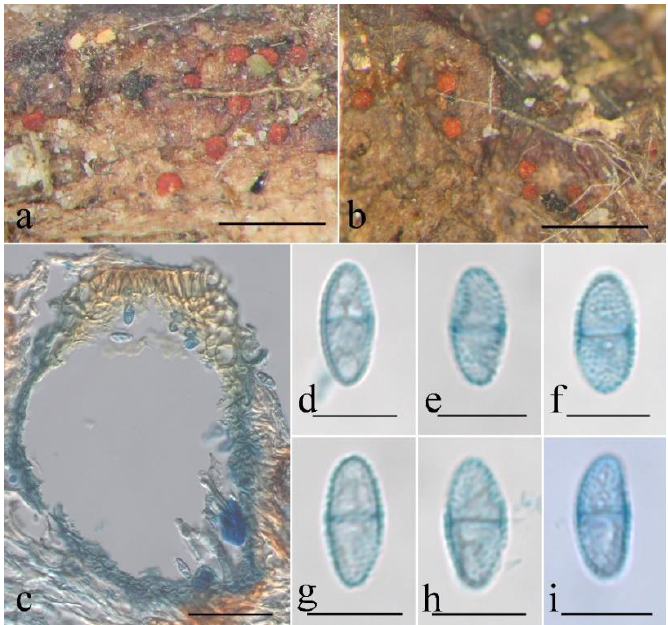
Figure 10. Macroscopic and microscopic morphology of Thelonectria spinulospora (HMAS 290897). ( a , b ) Ascomata on natural substratum; ( c ) median section of perithecium in lactophenol cotton blue; ( d – i ) ascospore in lactophenol cotton blue. Bars: ( a , b ) = 1 mm; ( c ) = 50 μm; ( d – i ) = 10 μm.